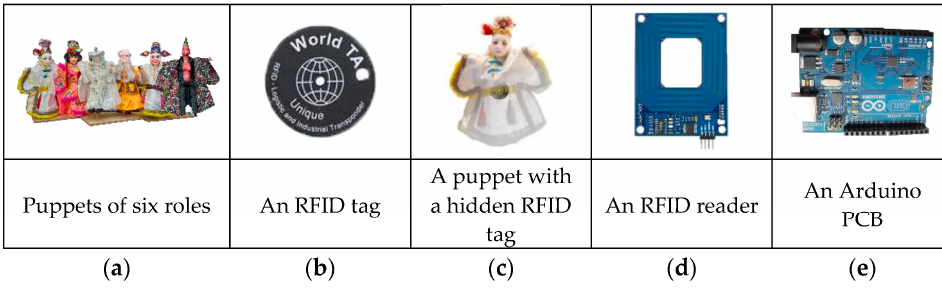
Figure 7. Puppets and hardware parts used in this study. ( a ) Puppets of six roles. ( b ) An RFID tag. ( c ) A puppet attached with an RFID tag from inside. ( d ) An RFID reader. ( e ) an Arduino PCB.